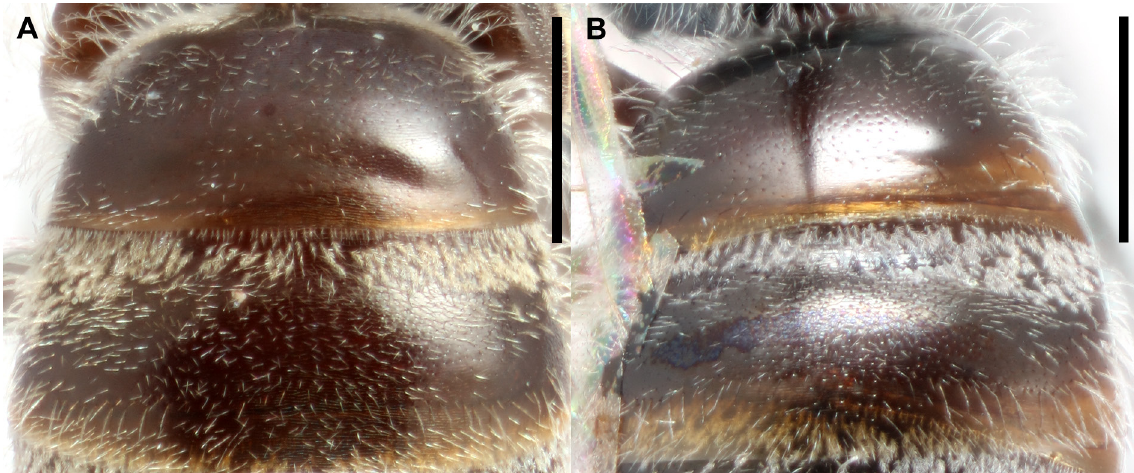
Fig. 91. T1–T2. A . Lasioglossum stictaspis (Sandhouse, 1923), ♀, dull and finely, somewhat obscurely punctate. B . L. gaudiale (Sandhouse, 1924), ♀, shiny and deeply, distinctly punctate. Scale bars = 0.5 mm.